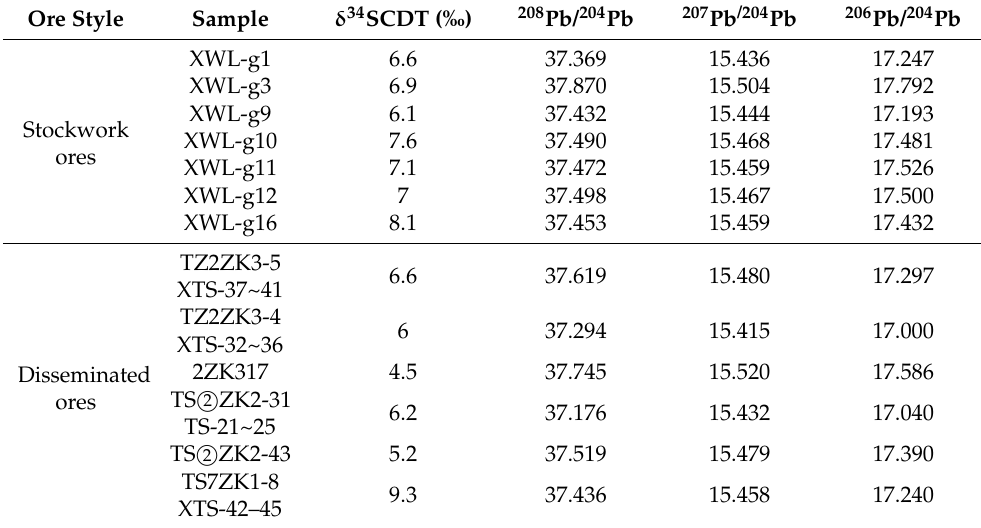
Table 4. Sulfur isotopic compositions and lead isotopic ratios of pyrite in the Xiawolong gold deposit.